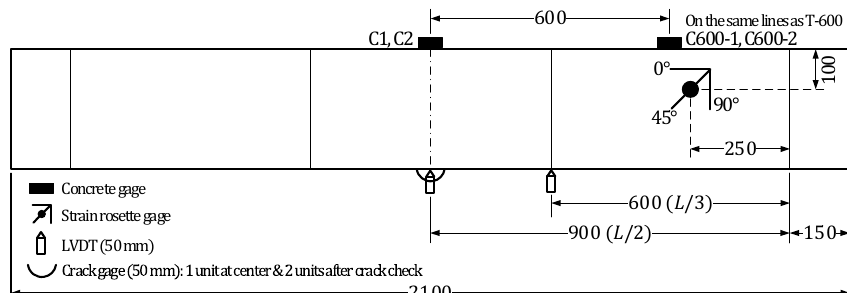
Figure 5. Setup for 4-point loading test.